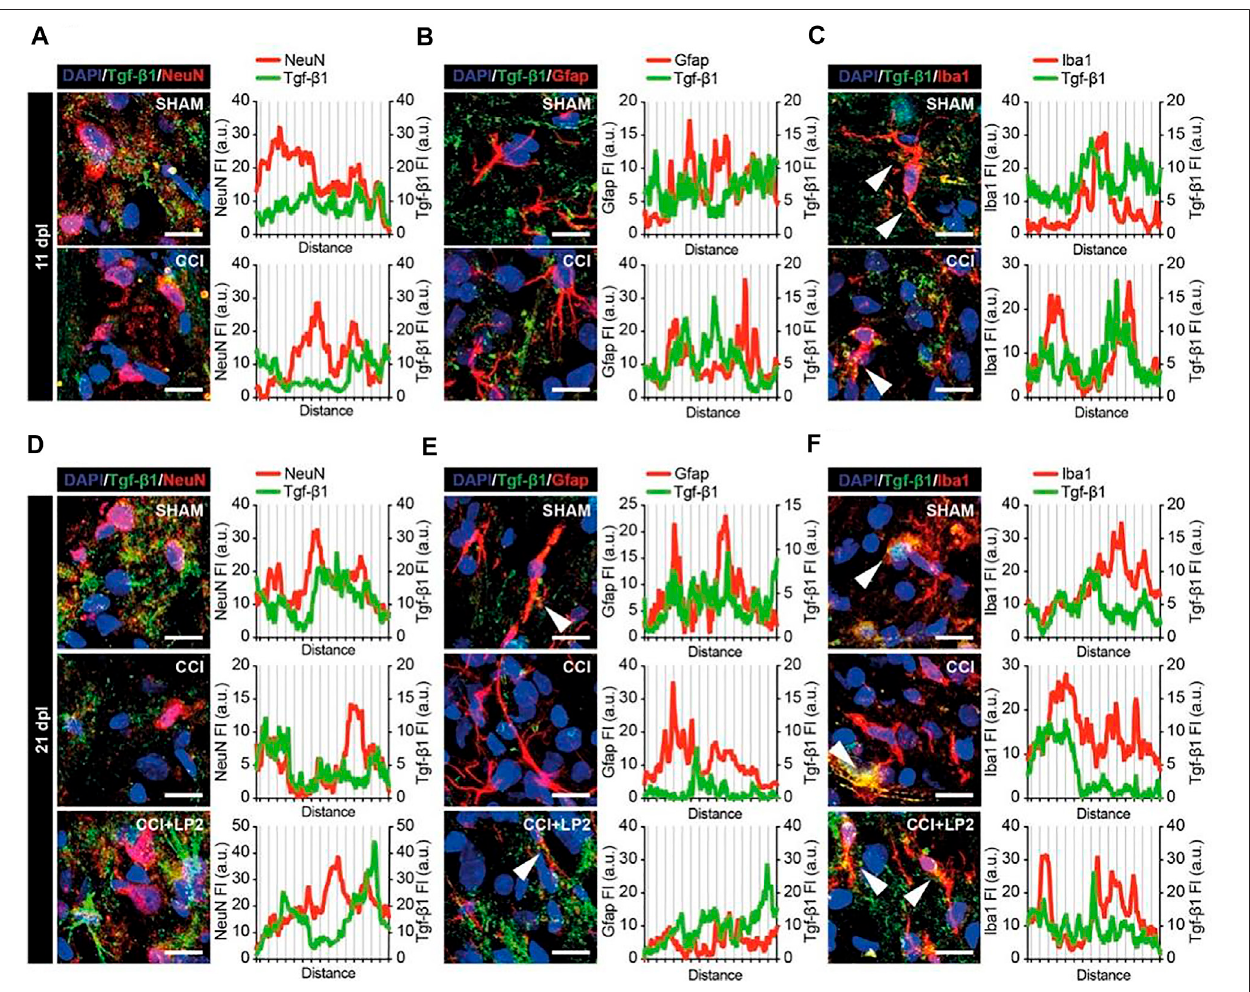
FIGURE 5 | TGF- β 1 pro fi le in neurons, astrocytes and microglial cells in ipsilateral dorsal horns of CCI spinal cord. Representative confocal images of TGF- β 1 (green) and NeuN ( red in A – D) , GFAP ( red in B – E ) and Iba1 ( red in C – F) immunohisto fl uorescence analysis in ipsilateral dorsal horns of SHAM and CCI rats at 11 dpl (A – C) andofSHAM,CCIandCCI+LP2treatedratsat21dpl (D – F). Scalebars10 μ m.Pro fi leplotsofmean fl uorescenceintensity,expressedasarbitraryunits(a.u.),are also